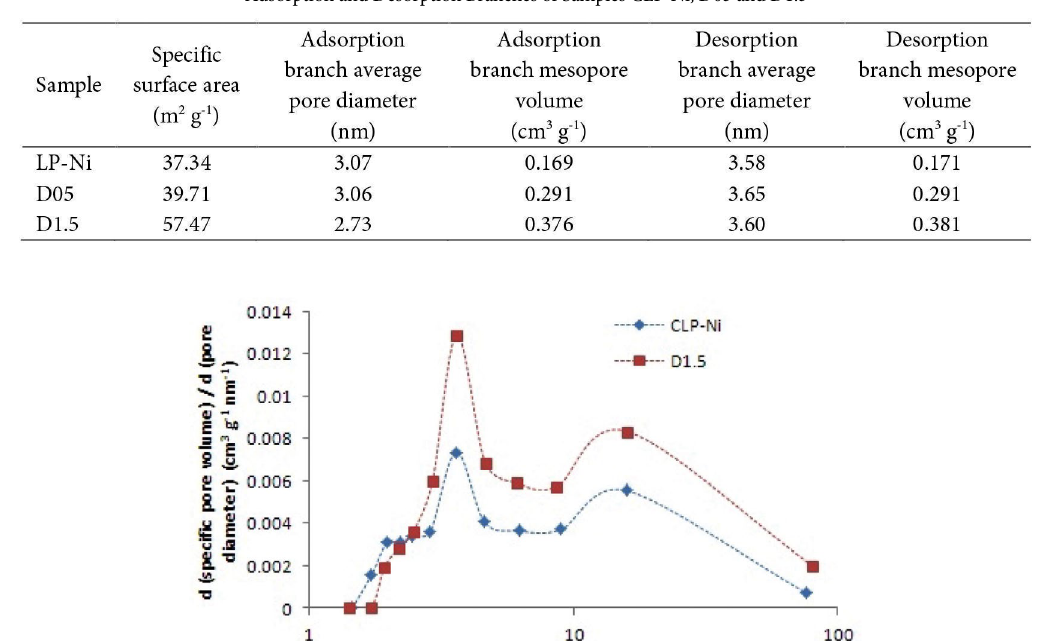
Table 2. Specific Surface Area, Average Pore Diameter and Pore Volume Calculated Based on the BJH Theory from the Experimental